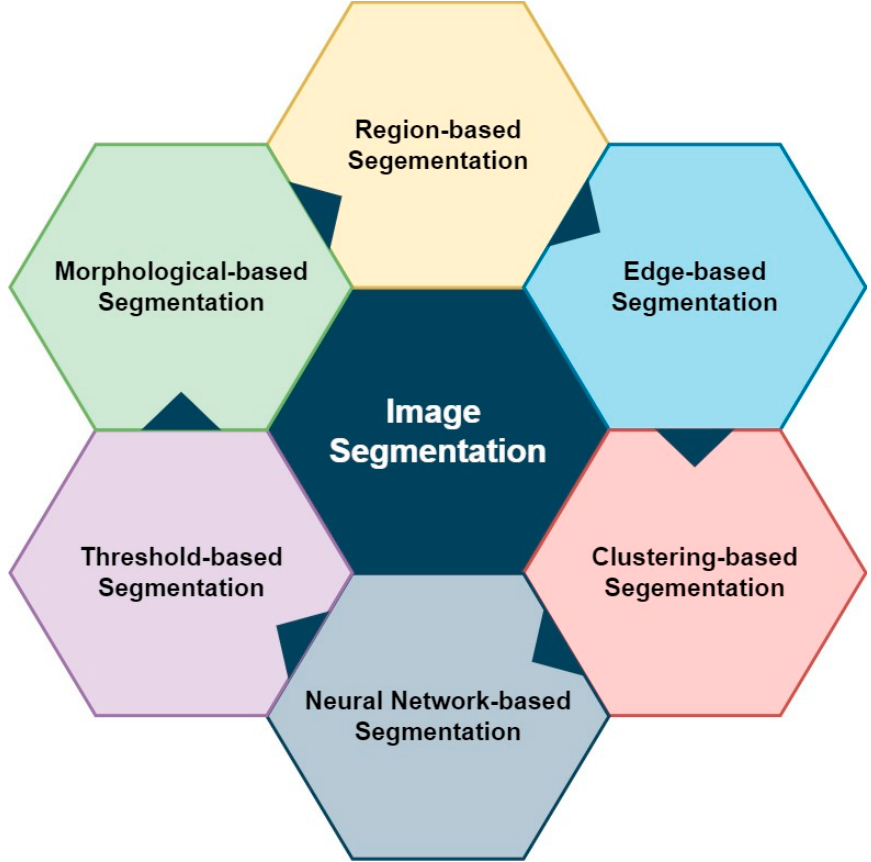
Figure 20. Image segmentation.